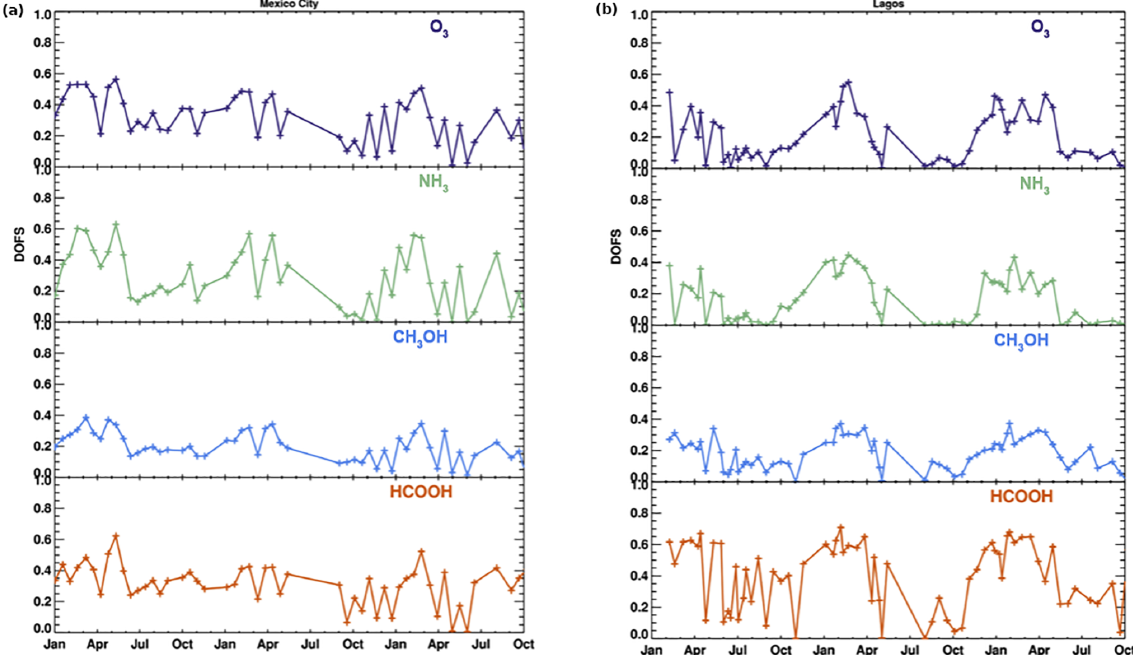
Figure A2. Time series of the DOFS over the MCMA (a) and the Lagos area (b)